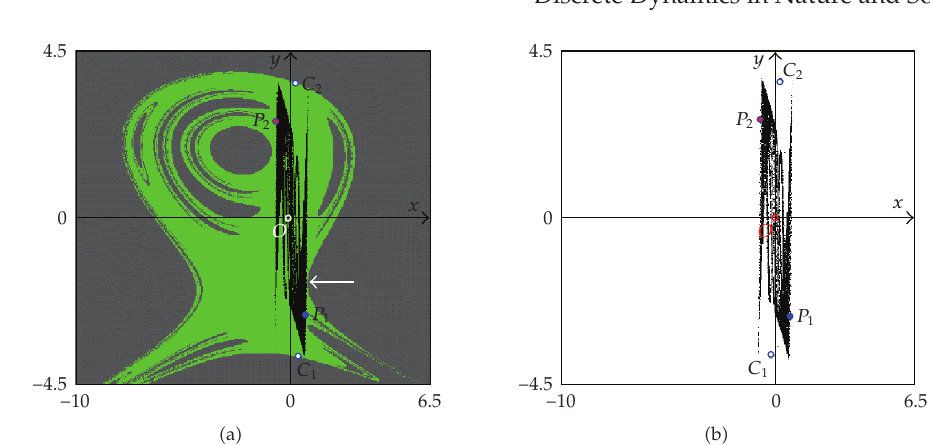
Figure 14: Homoclinic bifurcation of O and final bifurcation. In (cid:5) a (cid:6) , the value of e is 4 . 893 , while in (cid:5) b (cid:6) e (cid:8) 5 .